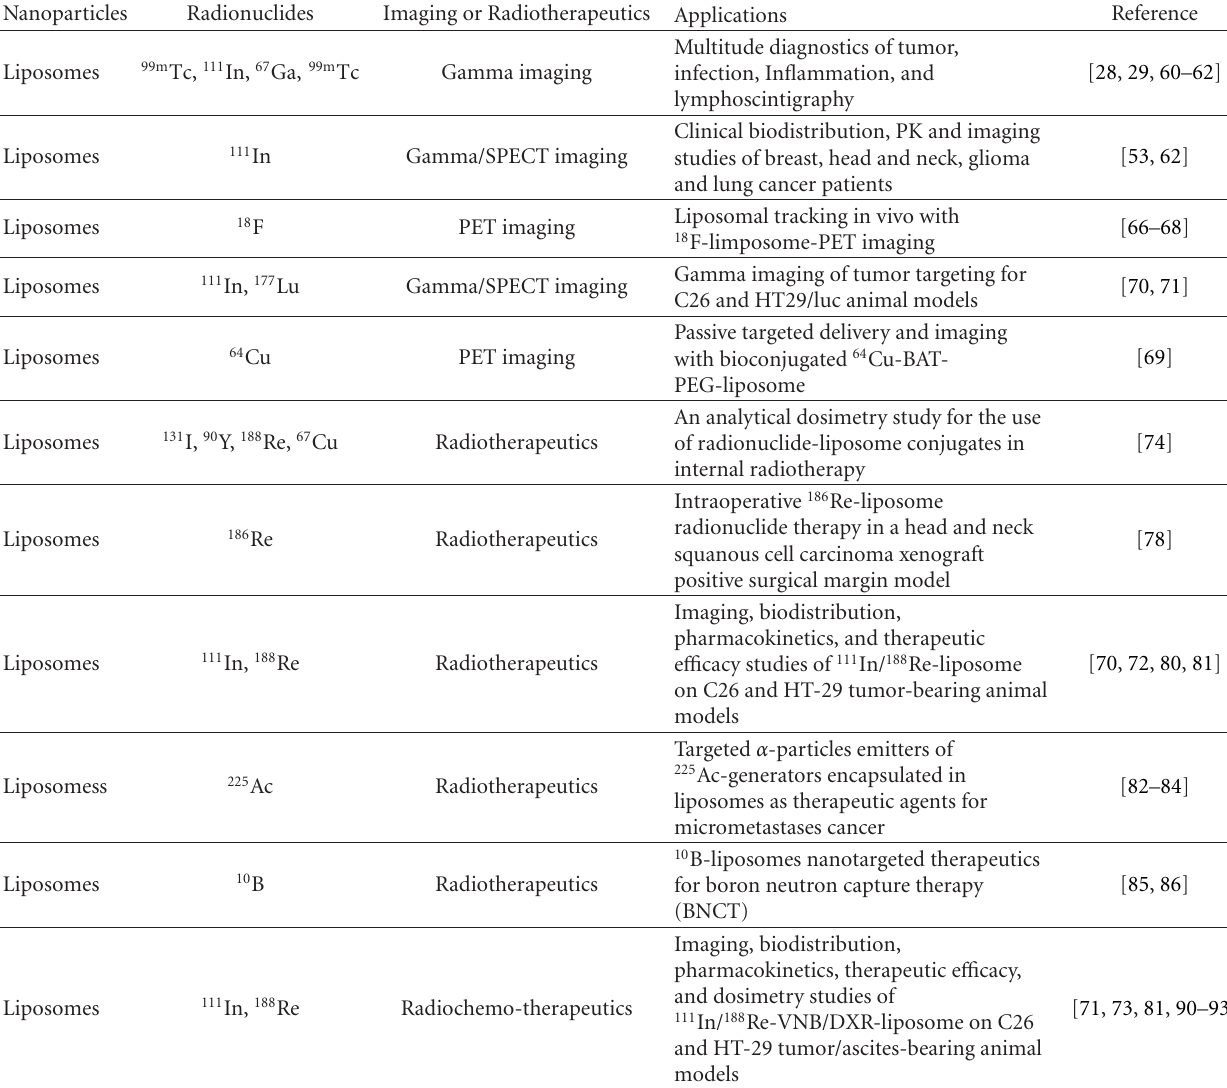
Table 4: Selected passively nanotargeted tumor nuclear imaging and radiotherapeutic